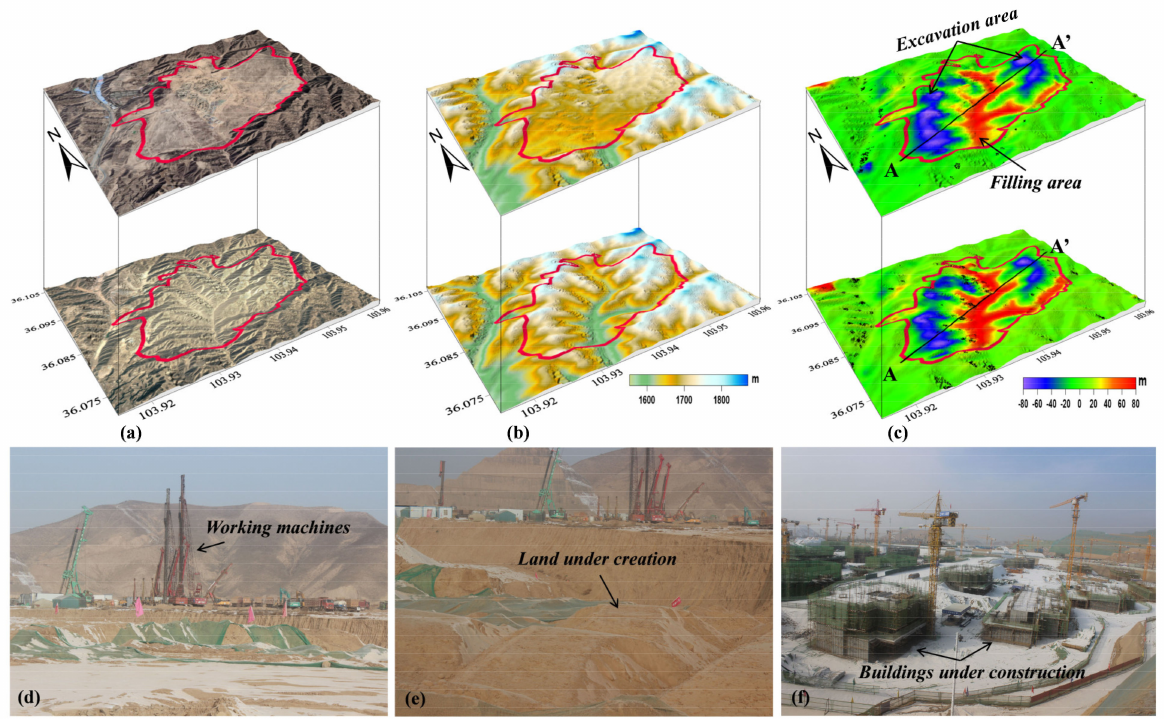
Figure 17. ( a ) Remote sensing images of Region E (see location in Figure 11) before (bottom) and after (top) creating land, which were acquired on 16 March 2011 (bottom) and 24 February 2021 (top), respectively. ( b ) Terrain elevation of Region E before (bottom) and after (top) creating land; ( c ) estimated DEM errors in Region E from ascending (top) and descending (bottom) Sentinel-1 images; ( d – f ) scene pictures of Region E taken in January 2021. Note that the red line indicates the boundary of the land creation in Region E.